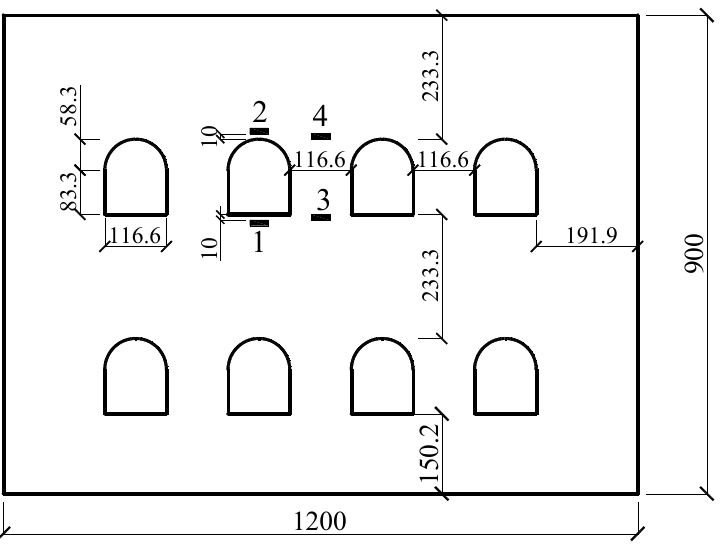
Figure 12. Stress monitoring points (unit: mm).